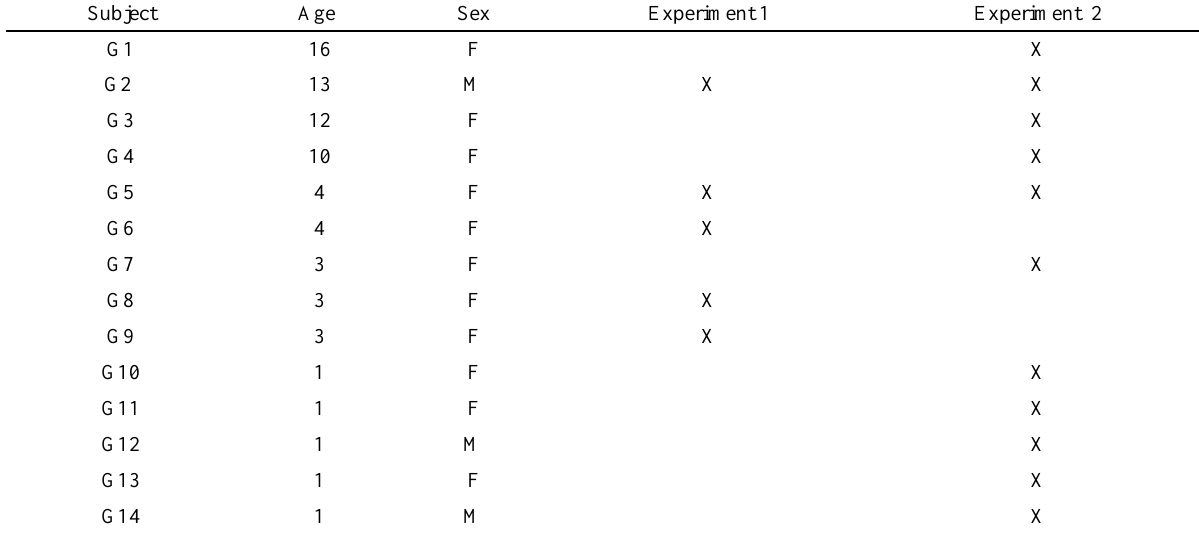
Subjects for the Study Examining Scent Preferences and Effects on